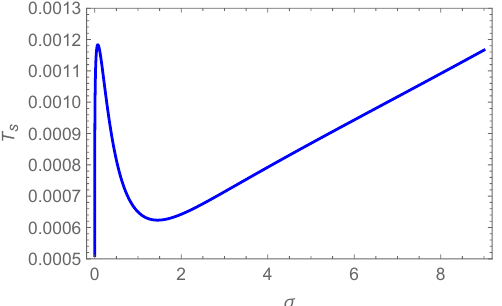
Figure 3 . The system temperature T s as the function of the parameter σ . The non-monotonicity is shown explicitly. In this plot, q = 50 , J = 1 , and ˆ µ = 0 . 1